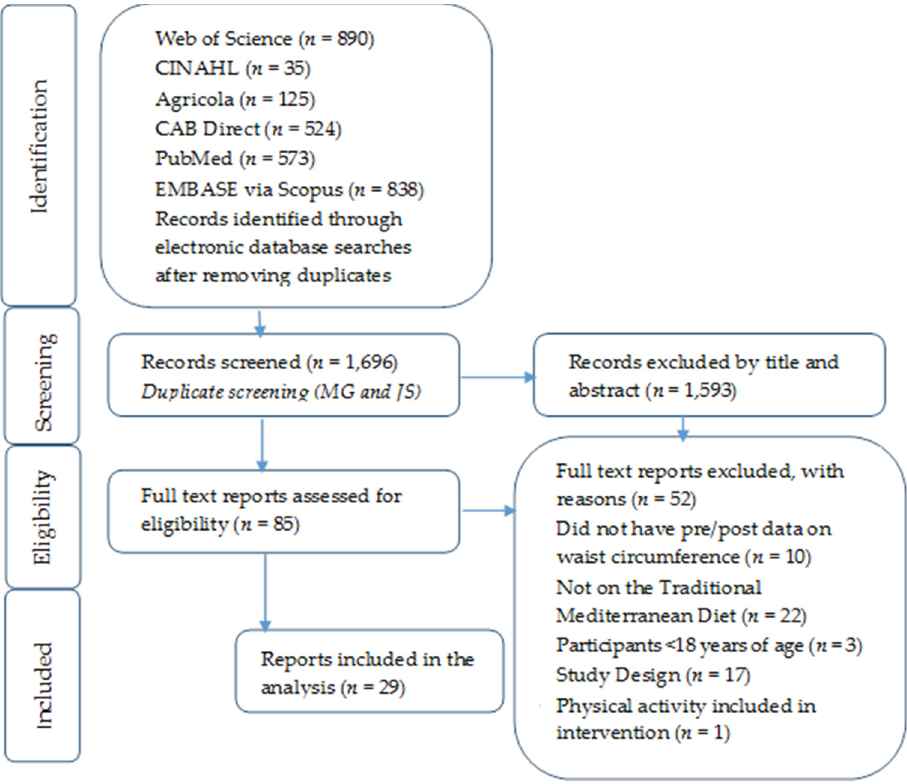
Figure 1. PRISMA Figure outlining the process of study identification, screening, eligibility, and inclusion.